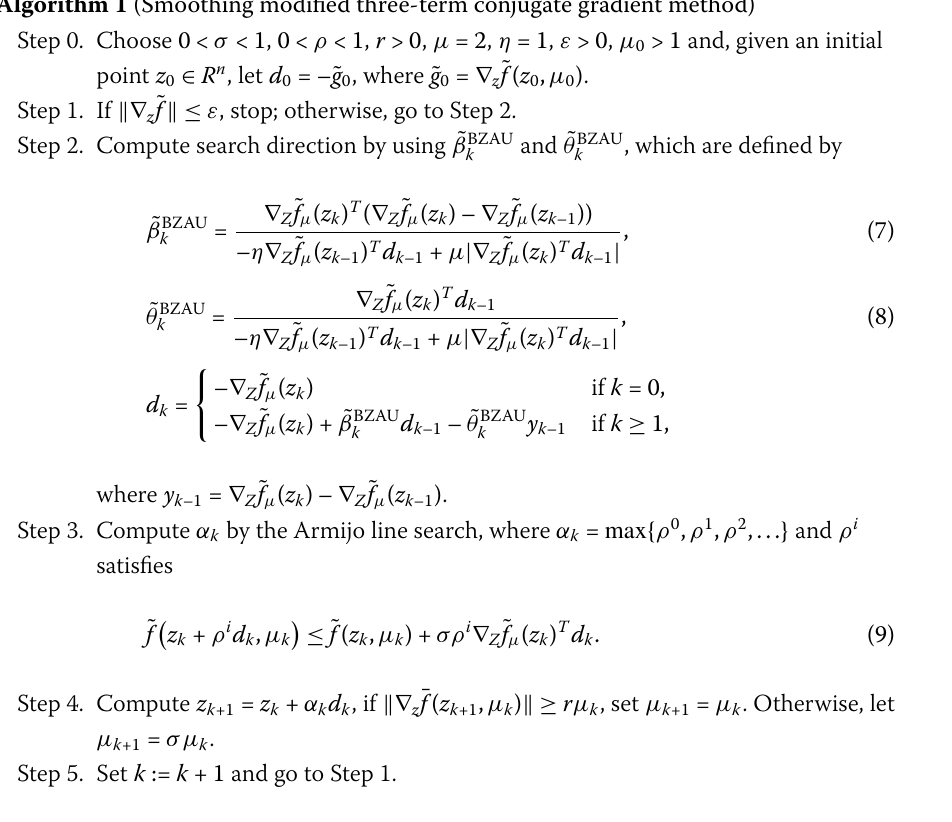
Algorithm 1 (Smoothing modified three-term conjugate gradient